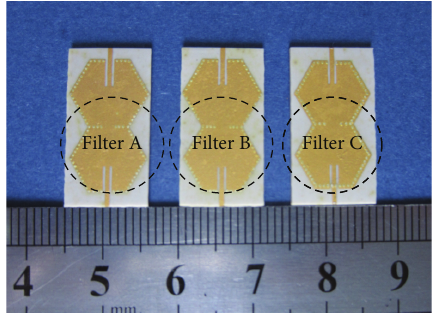
Figure 6: Photographs of fabricated Filters A, B and